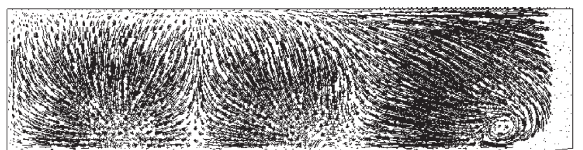
Figure 11: Plane velocity vector diagram with a 60 ° lateral angle 2-2.